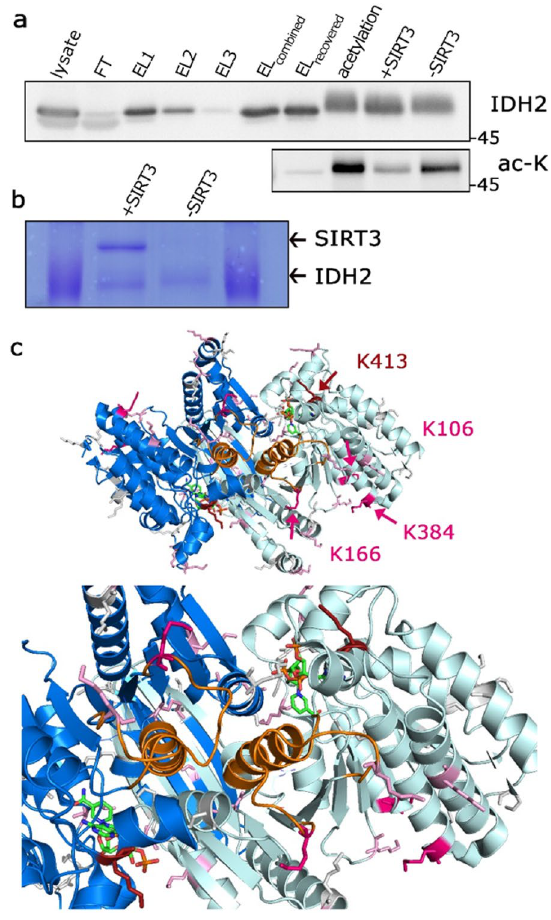
Figure 2. SIRT3 deacetylates IDH2 in vitro . (a) Western blot analysis of the purified IDH2, indicating that treatment of acetylated IDH2 (“acetylation”) with recombinant SIRT3 deacetylates IDH2, performed with anti- IDH2 and anti-acetyl-lysine antibodies. Western blot was performed using equimolar amount of protein. The lanes contain following fractions: whole cell lysate ( lysate ), flow-through ( FT ), three sequential steps of elutions ( EL1 , EL2 , EL3 ), combined three elutions ( EL combined ), following recovery by 10 K Amicon ( EL recovered ), protein after acetylation step ( acetylation ), protein after treatment with recombinant SIRT3 ( + SIRT3 ), and parallel sample without SIRT3 ( − SIRT3 ). (b) Coomassie blue-stained PAGE of the purified IDH2 used for LC-MS analysis of acetylated lysines with indicated recombinant SIRT3. C) Model depicting IDH2 structure with NADPH. The reaction center is depicted in orange, K413 in red, K106, 166, and 384 in magenta, other possibly acetylated/deacetylated lysines in